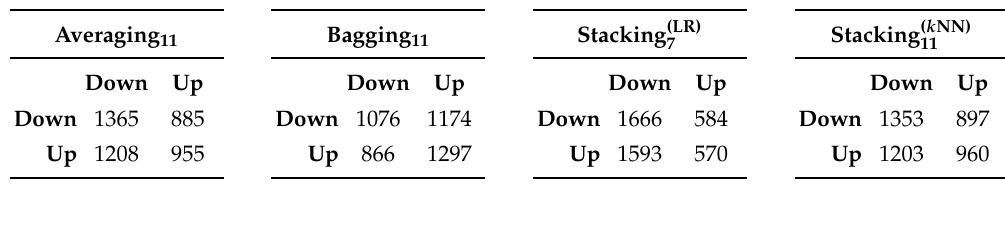
Table 9. Confusion matrices of Averaging 11 , Bagging 11 , Stacking (LR)